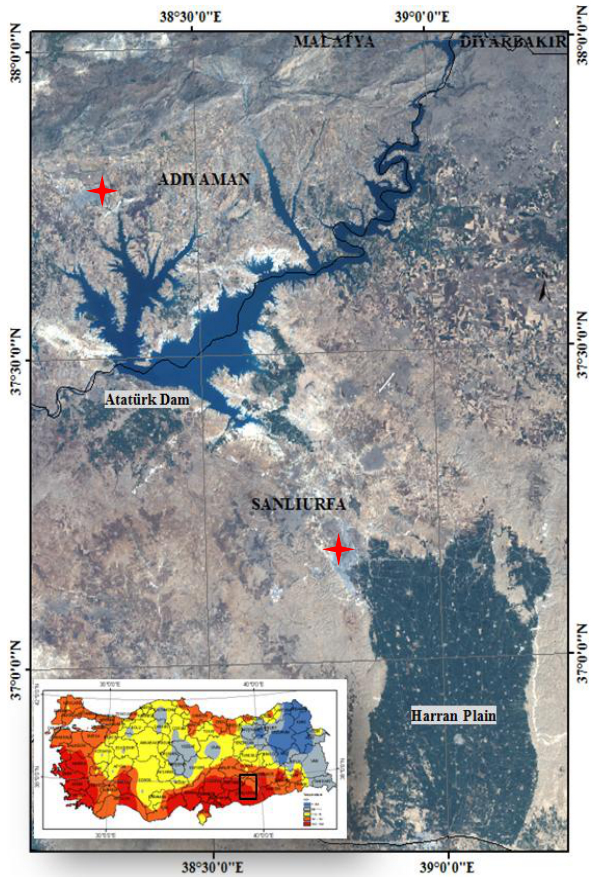
Fig. 2 Landsat TM images of the study area (August 2011). Inset shows mean annual temperature of Turkey with the study area outlined by a black